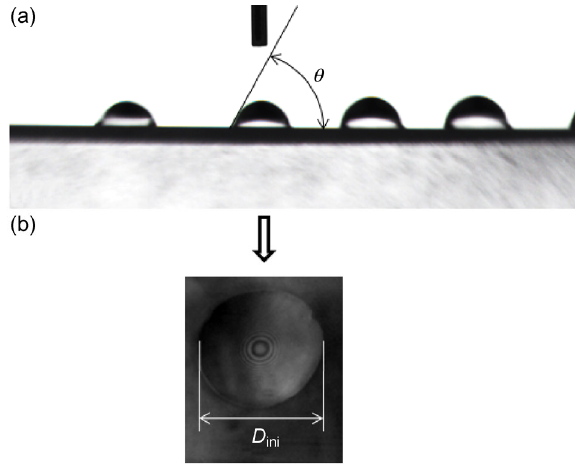
Fig. 2 Oil droplets arrangement and their shape (PAO100, Cr surface): (a) side view; (b) top view.